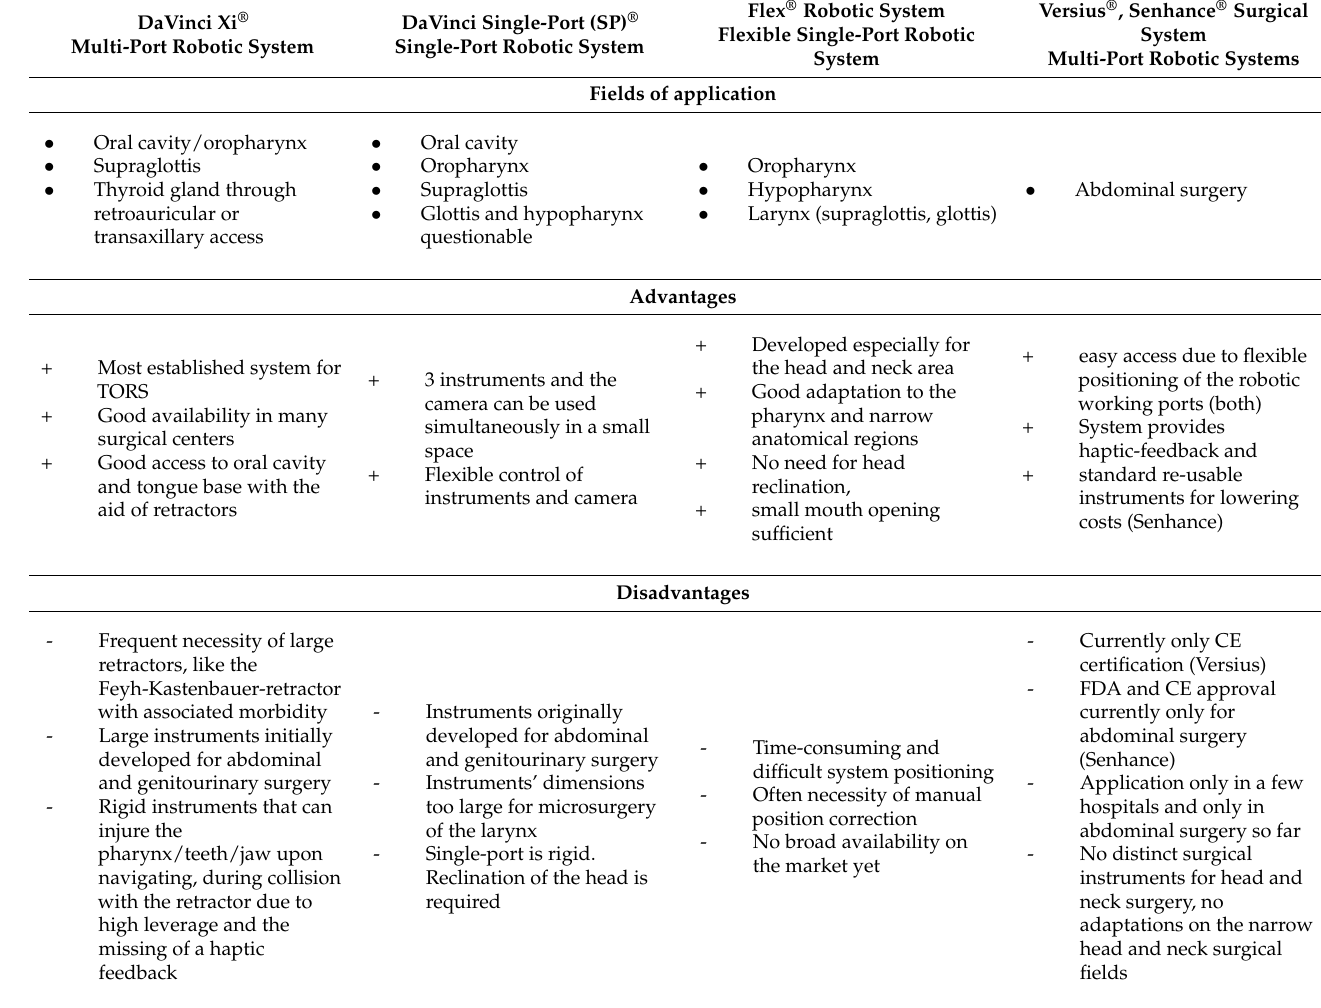
Table 1. Summary of commercially available robotic systems with FDA/CE approval and possible application in head and neck